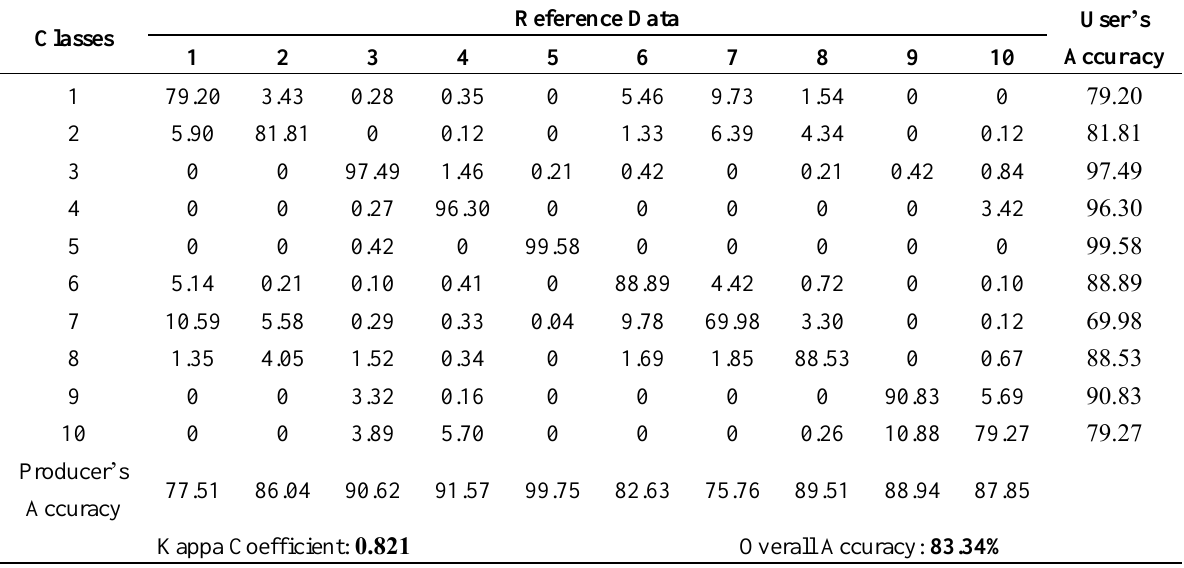
Table 3. The classification error matrix for data set IPS-10 (in percentage).